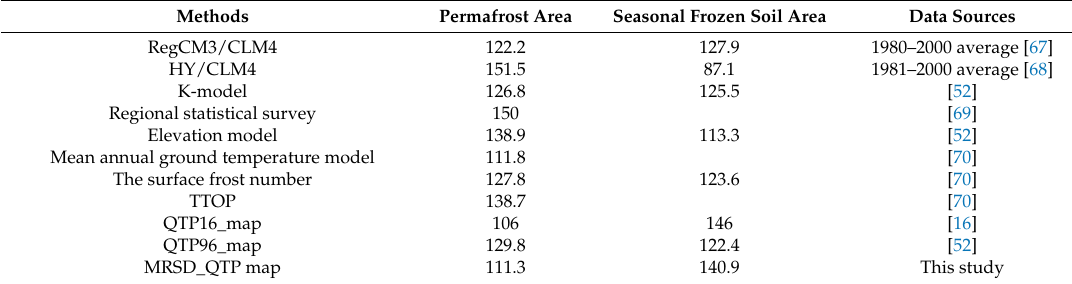
Table 6. Total area of frozen ground on the QTP, as calculated using different methods (Unit: 10 4 km 2 ).